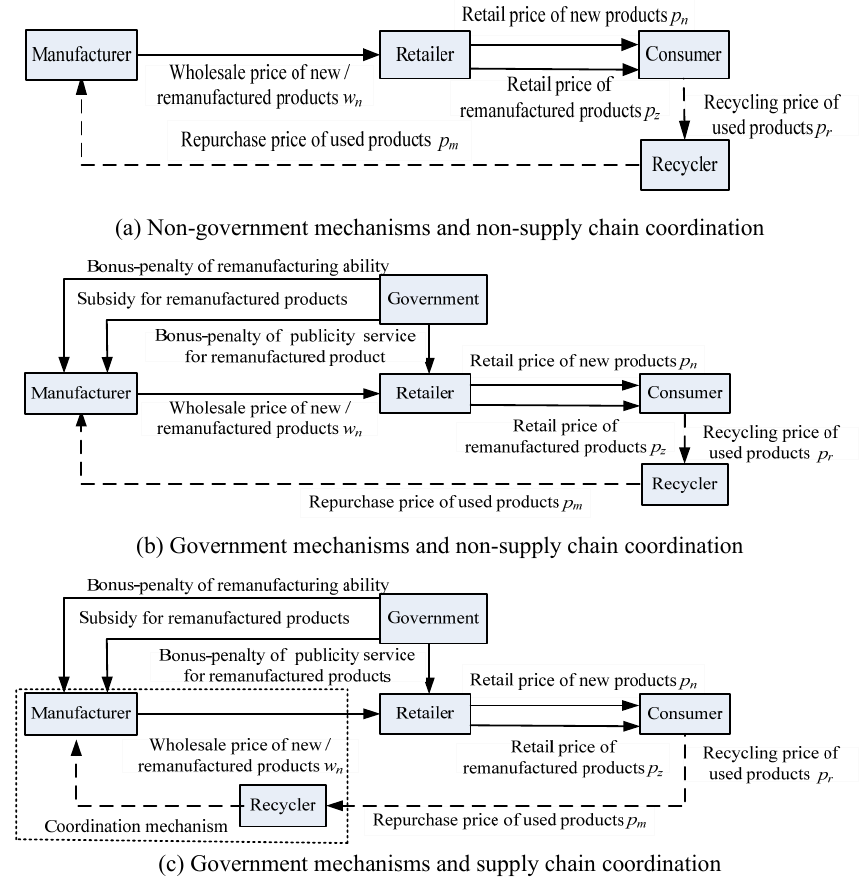
Fig. 1. Structure of five models in a recycling and remanufacturing supply chain.